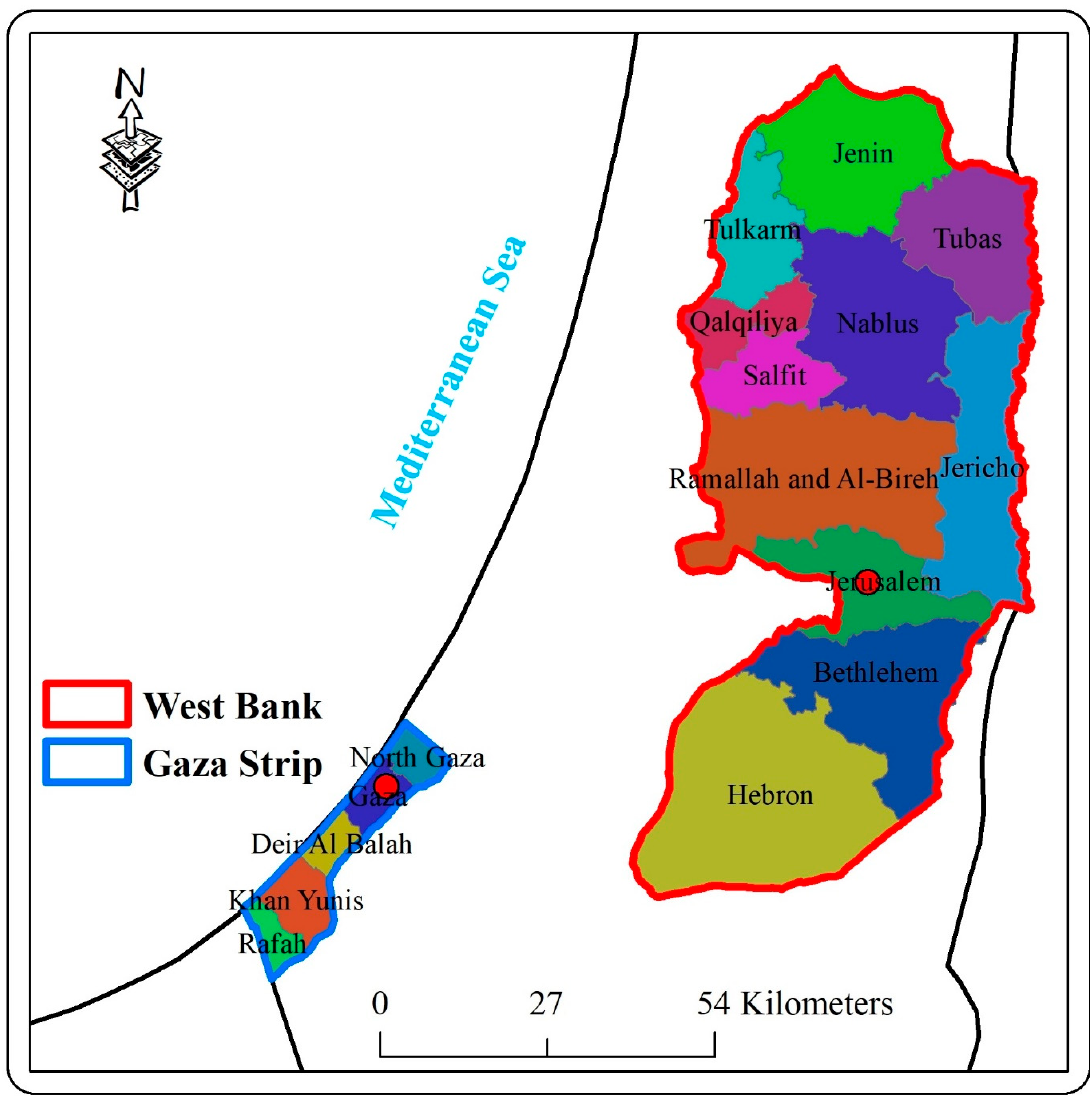
Figure 1. Map of the West Bank and Gaza Strip (Palestine).